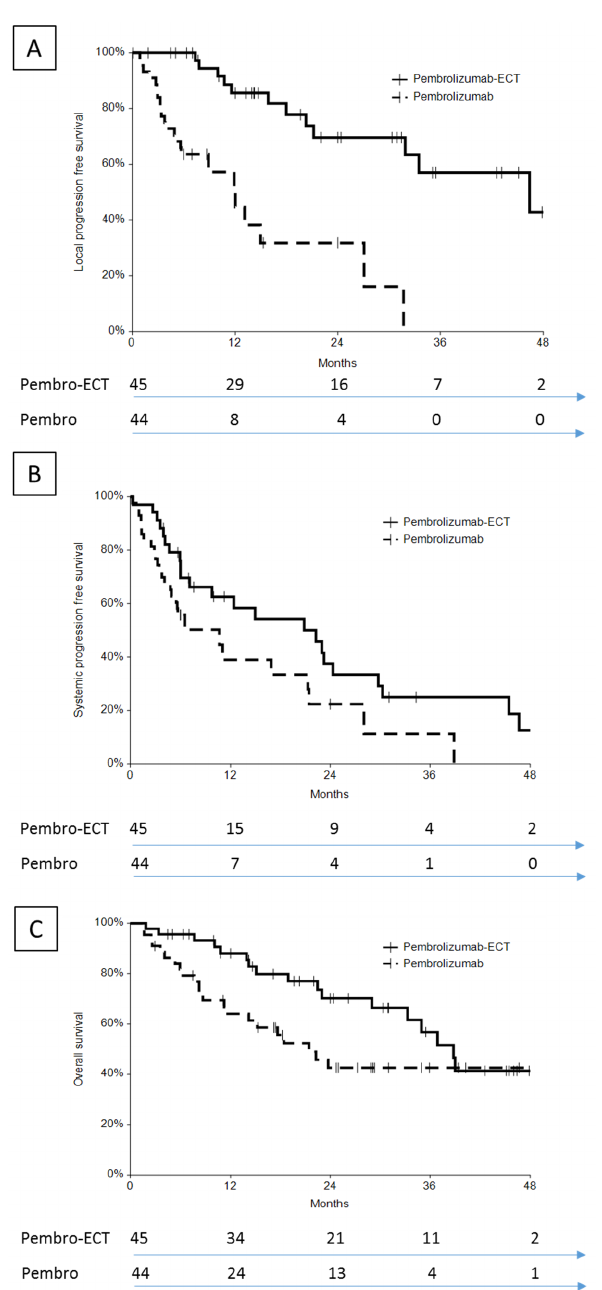
Figure 1. Outcome of patients treated with pembrolizumab–ECT or pembrolizumab alone: ( A ) local PFS; ( B ) systemic PFS; ( C ) OS. The number of patients at risk is indicated on the bottom.